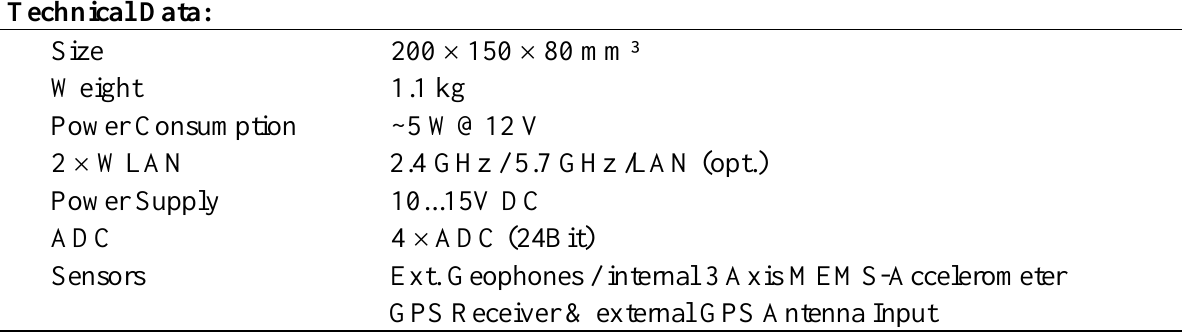
Table 1. Technical specifications of the low-cost Wireless Sensing Units.